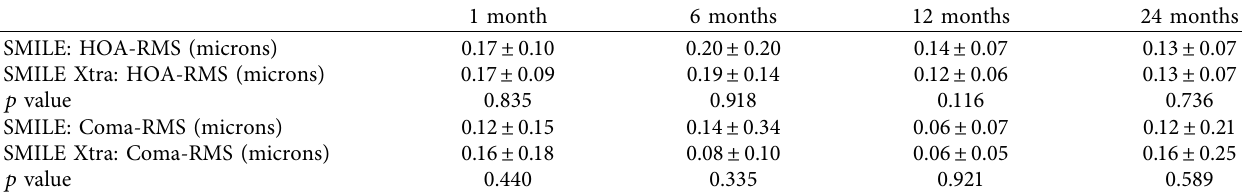
Table 4: HOA-RMS: high-order aberration root mean square; Coma-RMS: coma root mean